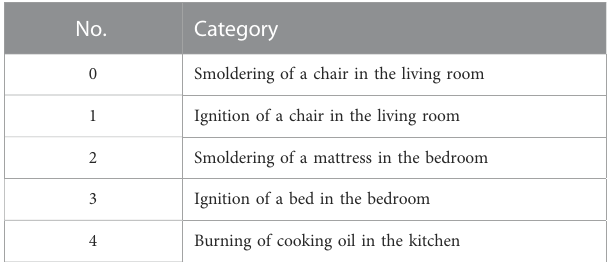
TABLE 1 Category matrix (Bukowski et al., 2003). No.